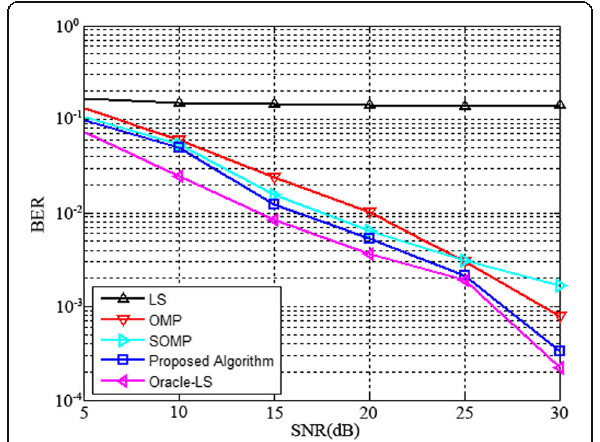
algorithm model in time-varying channel, the per- formance improvement effect is limited. OMP algo- rithm is less affected by noise in high SNR environment, every time the reconstructed channel